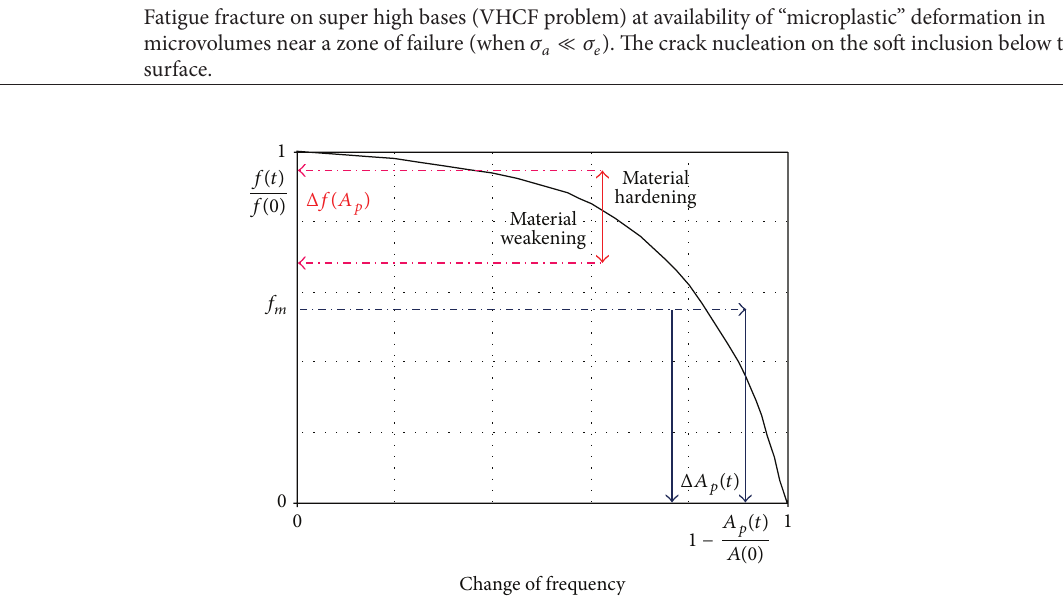
Figure 10: Lack of explicit copying of the size of the crack in the 1st modal frequency of blades